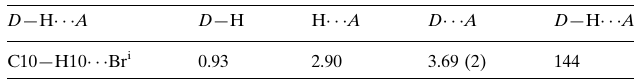
Hydrogen-bond geometry (A˚ , (cid:4)